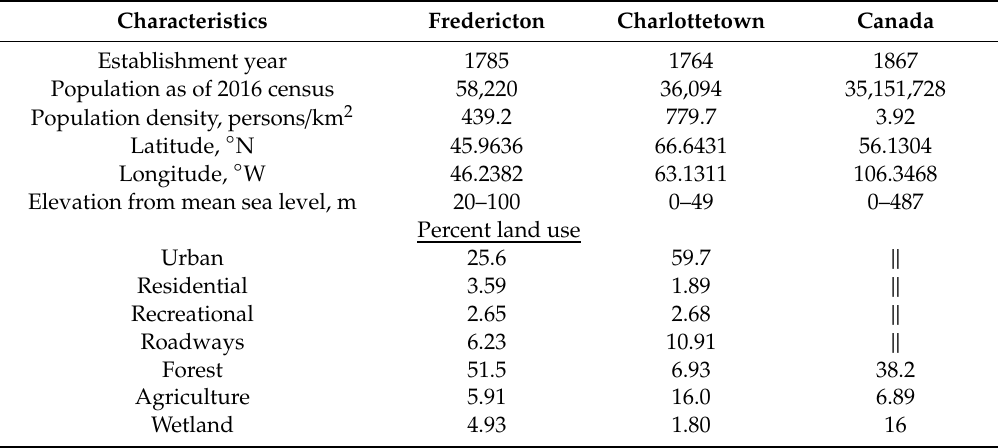
|| : Reliable data not